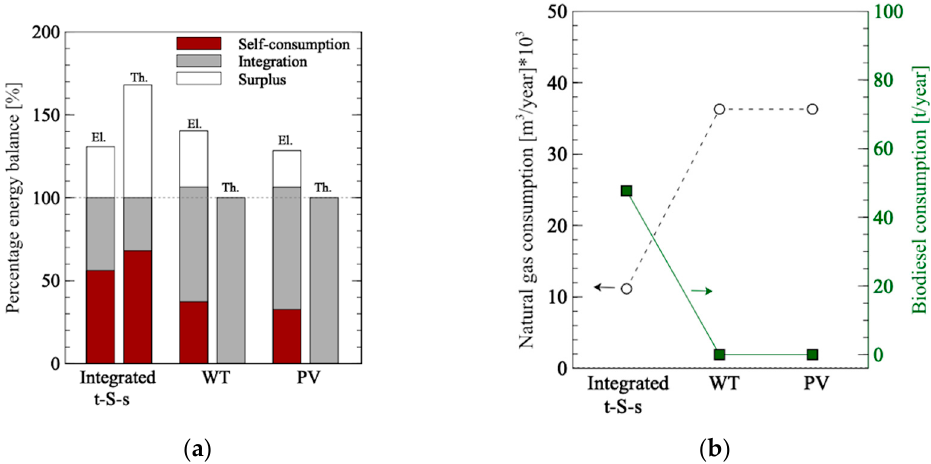
Figure 14. Comparison between multi-source energy system, WT and PV units in terms of annual electric energy balances ( a ) and fuel consumptions ( b ).